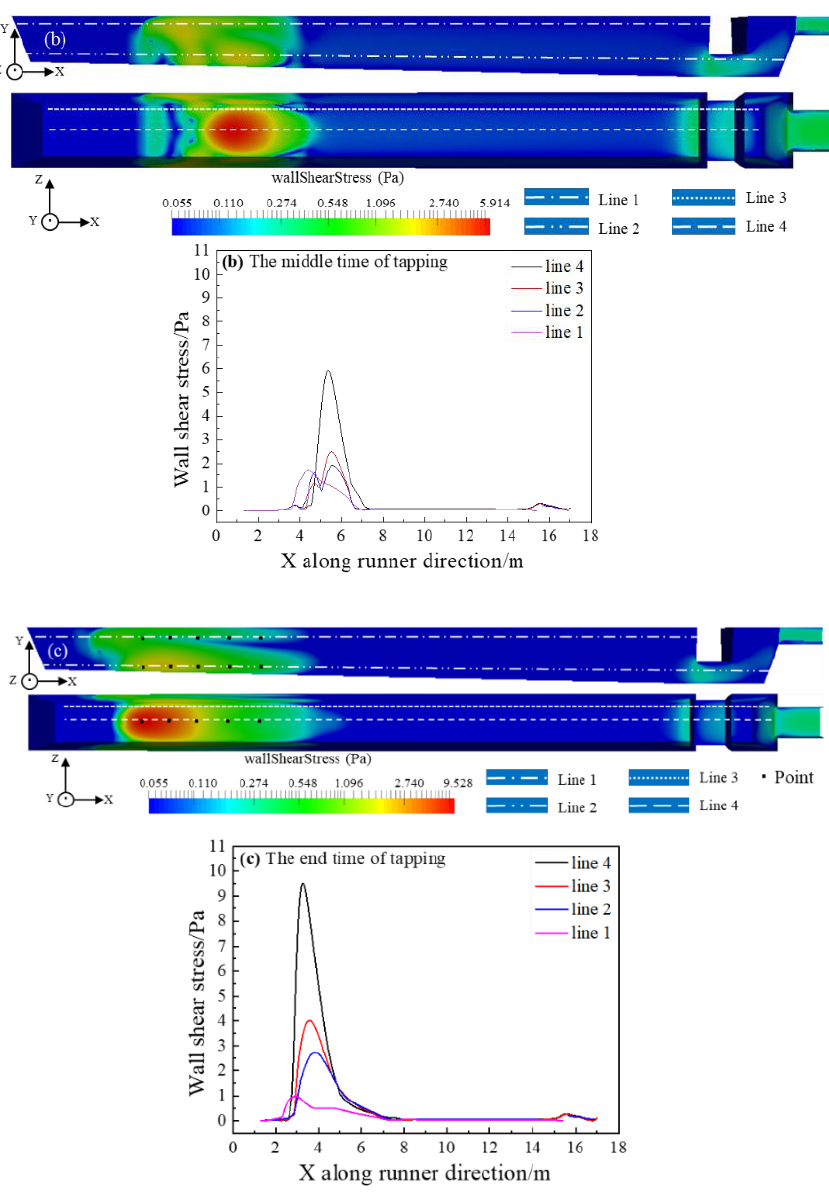
Figure 9. Wall shear stress distribution at three different times: ( a ) Beginning; ( b ) Middle; and ( c ) End.